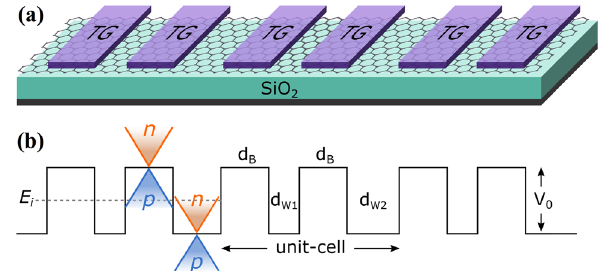
Figure 1. ( a ) Schematic representation of biperiodic graphene superlattices. Monolayer graphene is placed on a supporting substrate such SiO 2 and nanostructured with metallic electrodes or top gates (TGs) in biperiodic fashion. ( b ) Biperiodic potential profile along the superlattice axis. The superlattice unit-cell is composed of two metallic electrodes (barriers) and two inequivalent free regions (wells). V 0 and d B represent the height and width of barriers, while d W 1 and d W 2 the width of the first and second well in the superlattice unit-cell, respectively. Here, the number of superlattice periods is N = 3 . The n and p type regions in the superlattice structure are also highlighted. Depending on the energy of the incident charge carriers E i , it is possible to have three different transport regions: for E i > V 0 transport mediated exclusively by electrons, for 0 < E i < V 0 the transport is owing to electrons and holes, and E i < 0 the transport is mediated only by